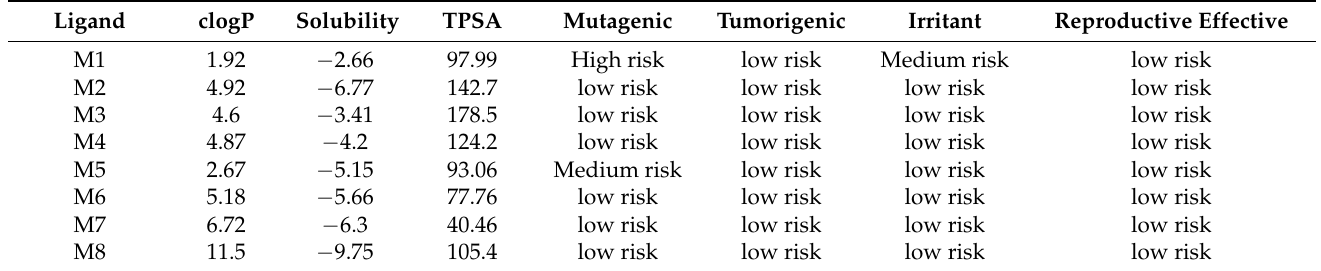
Table 5. Drug likeness prediction using OSIRIS Property